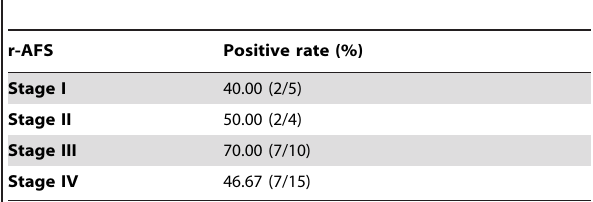
Table 5. Rates of chronic endometritis in each stage of endometriosis and comparison between early stages (I + II) and late stages (III +